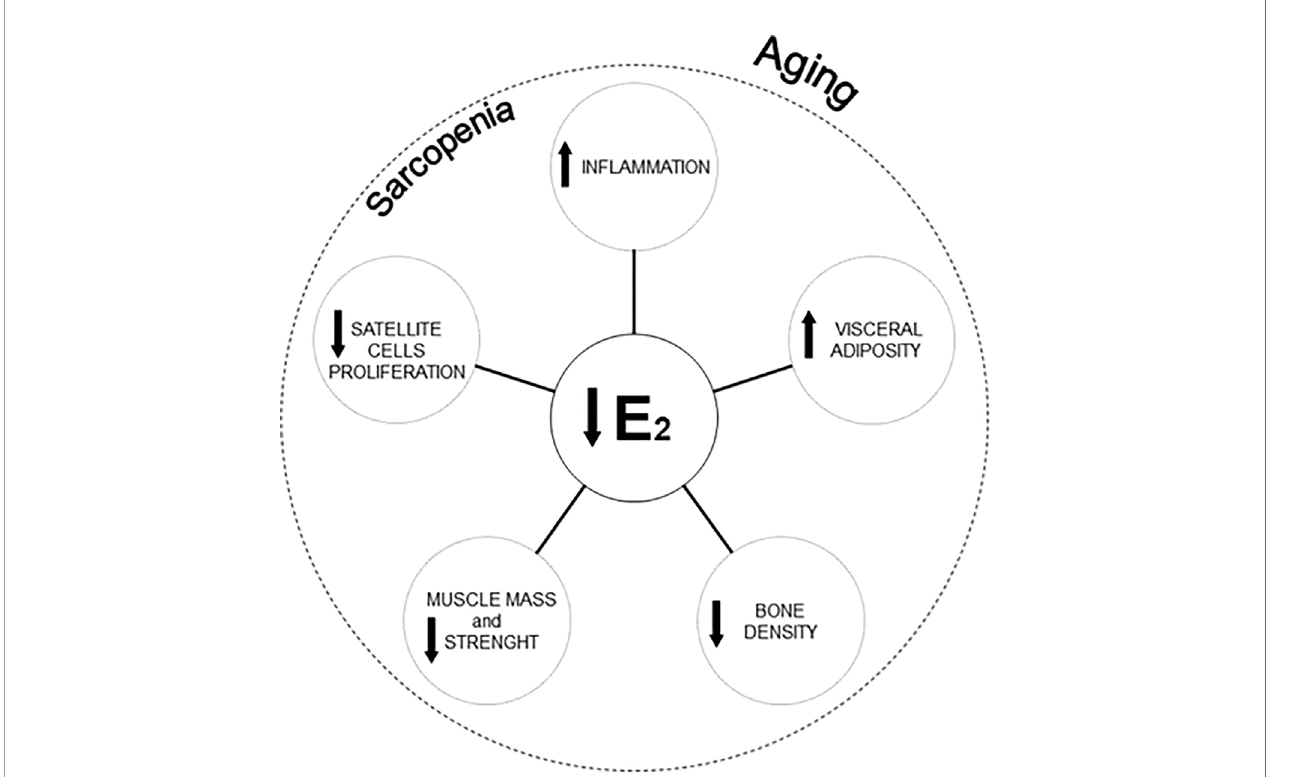
FIGURE 1 | Reduction of estradiol concentrations, morphological changes, and cellular modi fi cations affecting sarcopenia in women aging. E2,